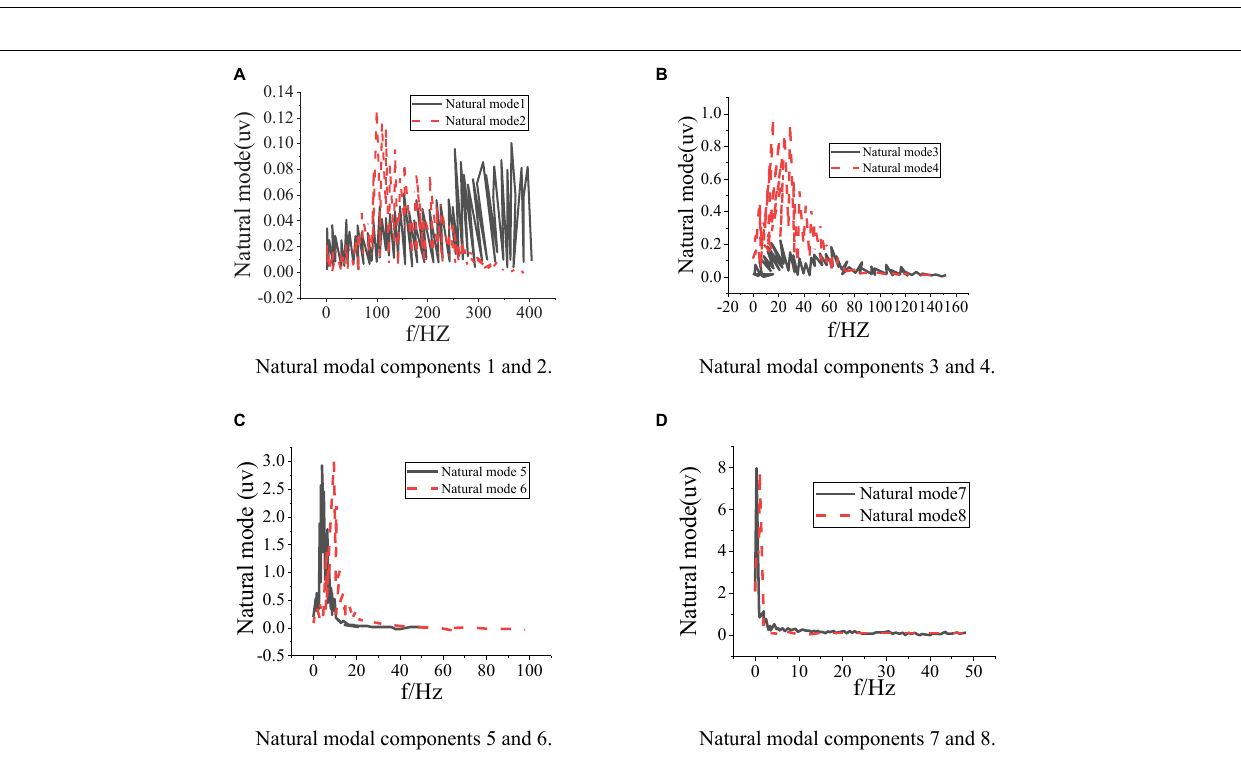
FIGURE 6 | Modal spectrum of each inherent brain signal. (A) Natural modal components 1 and 2. (B) Natural modal components 3 and 4. (C) Natural modal components 5 and 6. (D) Natural modal components 7 and 8.